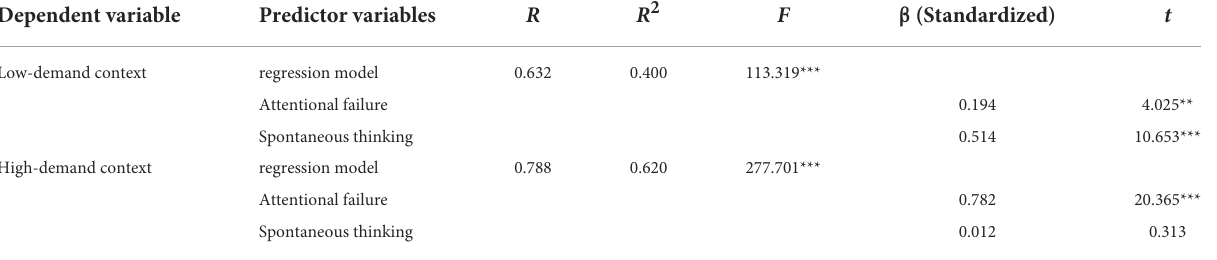
TABLE 4 Multiple regression analysis of the CMWS-F on